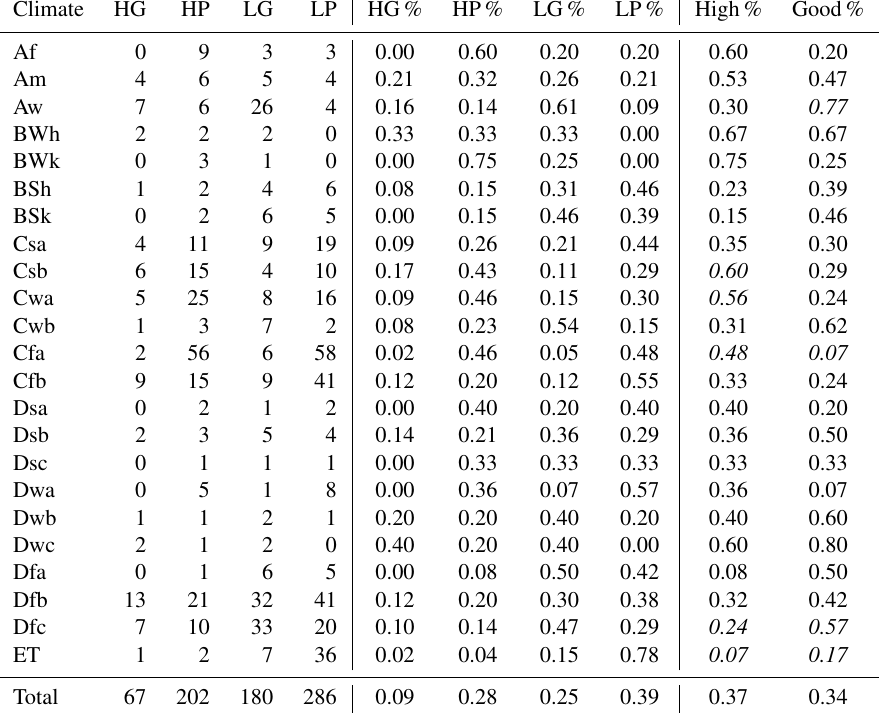
Table 3. Distribution of dams across climate zones. In columns 2–9, H and L indicate the potential ( high/low ) of benefiting of forecasts, while G and P indicate the quality ( good/poor ) of realistic forecast. Columns 2–5 (6–9) are the number (percentages) of dams in each group. The last two columns report the percentages of dams with high potential and good forecast , respectively. Values reported in italics indicate whether the observed frequency is statistically different from the expected frequency (global average in the final row) ( p < 0 . 05 using χ 2